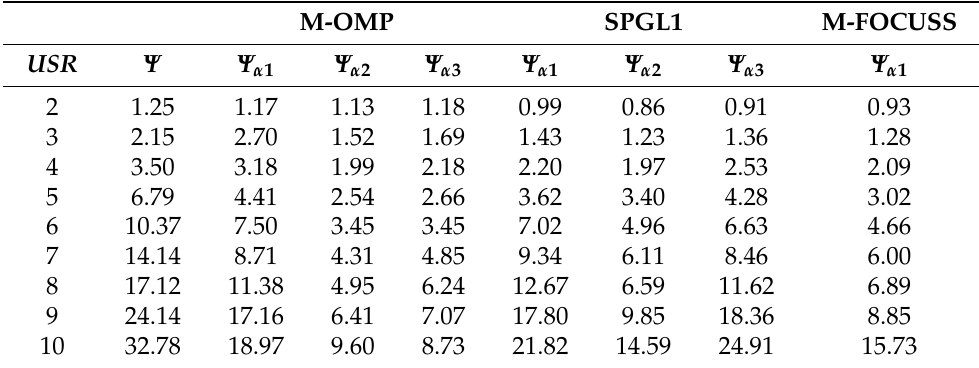
Table 3. Comparison of PRD values from the algorithms using the three dictionary matrices at several USR values, for ECG signal No. 103.